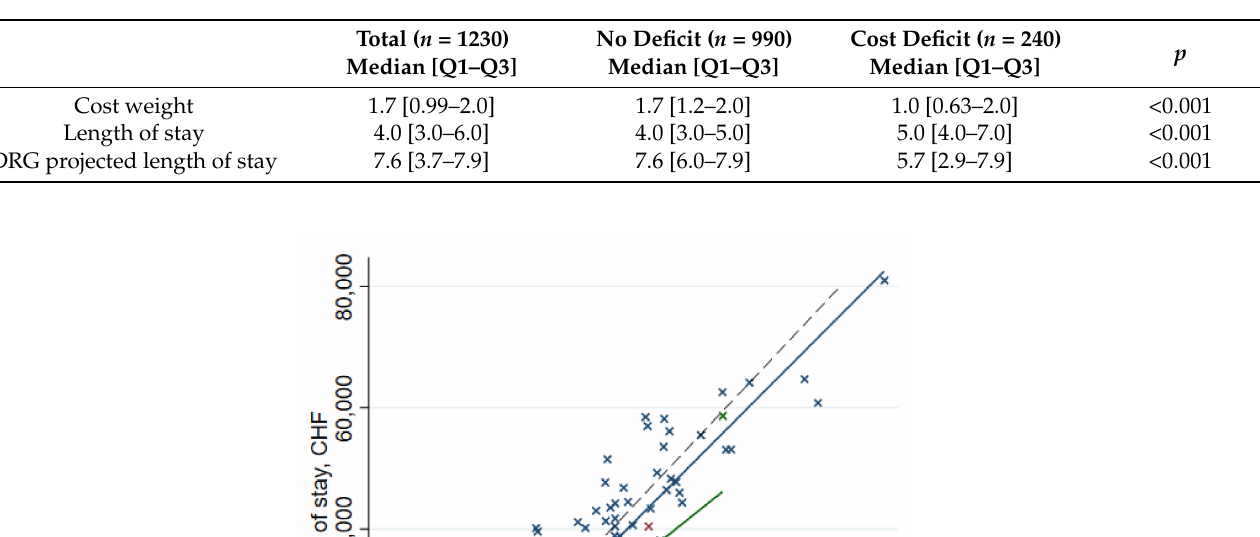
Table 5. Overview of DRG relevant data. Length of stay refers to the actual median length of patient stay, while DRG-projected length of stay refers to the median length of stay allocated by the DRG system for specific interventions.